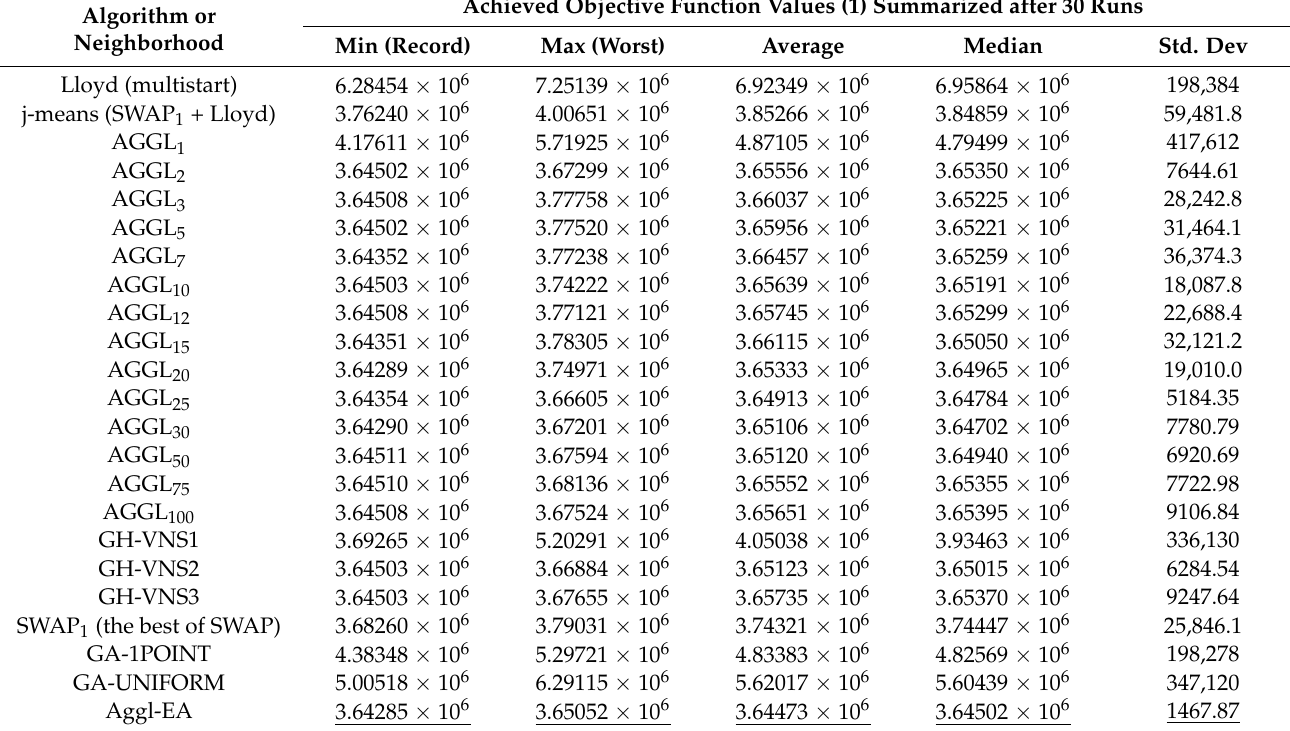
Table A14. Comparative results for Mopsi-Finland dataset. 13,467 data vectors in R 2 , p = 100 centers, time limitation 5 s. Algorithm